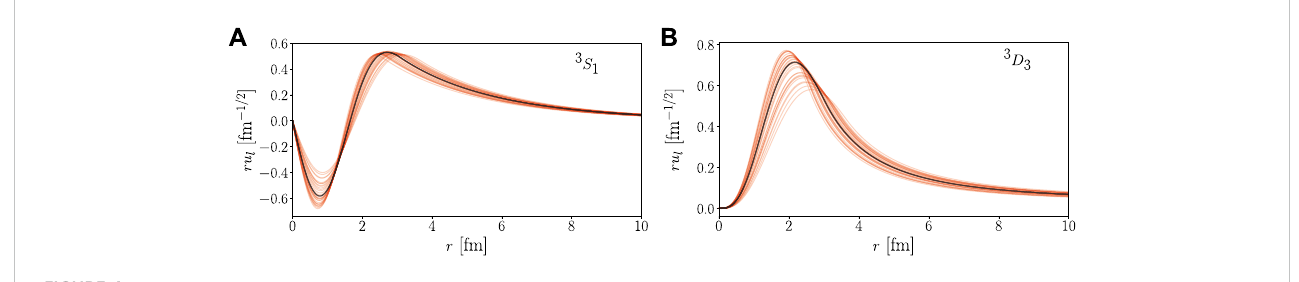
Table 1. The spread of the curves is given by the ± 10% variation in the LECs. The case for NNLO opt is shown in